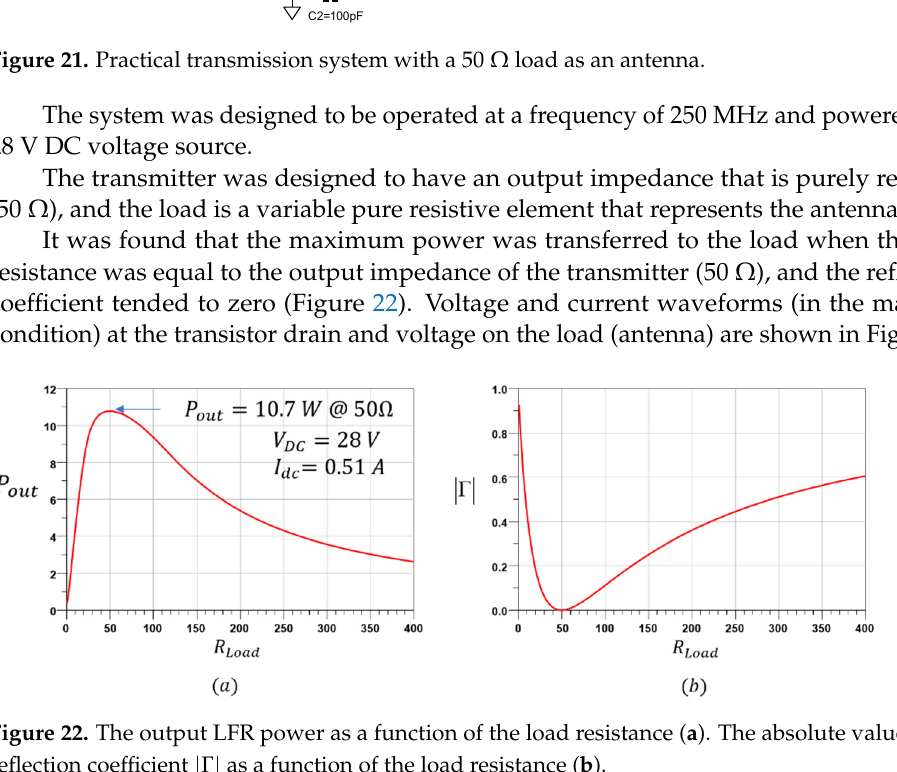
Figure 22. The output LFR power as a function of the load resistance ( a ). The absolute value of the reflection coefficient | Γ | as a function of the load resistance ( b ).